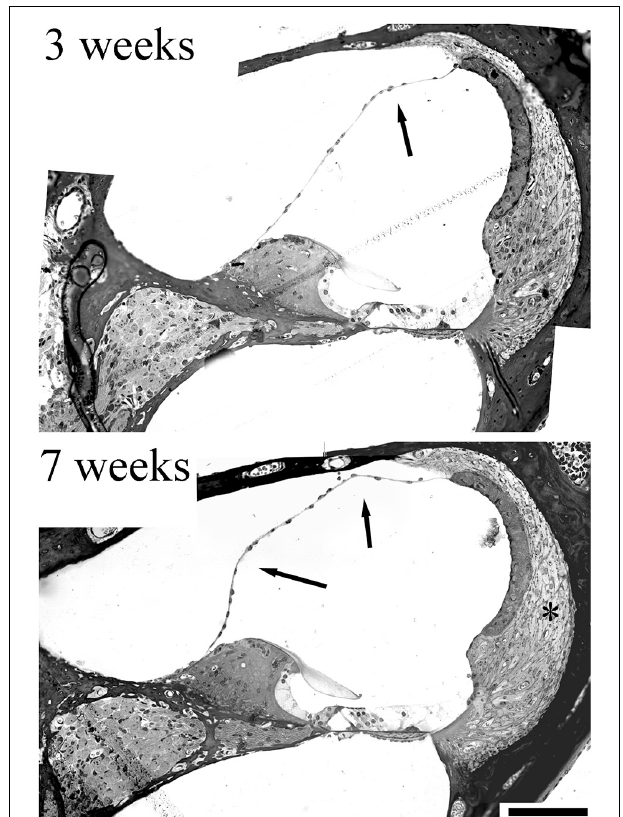
FIGURE 4 | Sections from a 3 week and 7 week CD/1 mouse cochlea showing accelerated age-related hearing loss. Fibrocyte degeneration in these mice has been reported (Mahendrasingam et al., 2011b) and can be seen as loss of cell nuclei/thinning of the tissue ( ∗ ). The evidence for progressive hydrops is indicated by the arrows, where Reissner’s membrane is distorted at 3 weeks, but this distortion becomes more exaggerated at 7 weeks, implying an increase in volume. Scale bar = 50 µ m (adapted with permission from Mahendrasingam et al., 2011b).